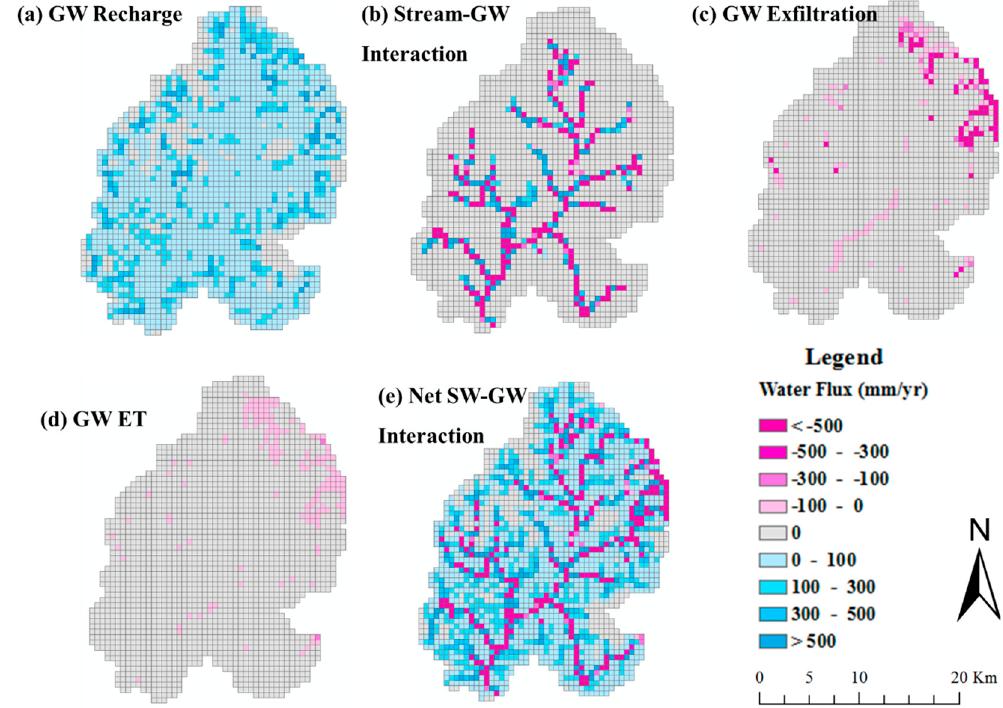
Figure 7. Spatial distribution of the surface water–groundwater (SW–GW) interaction fluxes in the Miho catchment. ( a ) GW recharge; ( b ) Stream–GW interaction; ( c ) GW exfiltration; ( d ) GW evapotranspiration (ET); ( e ) net surface water (SW)-GW interaction.